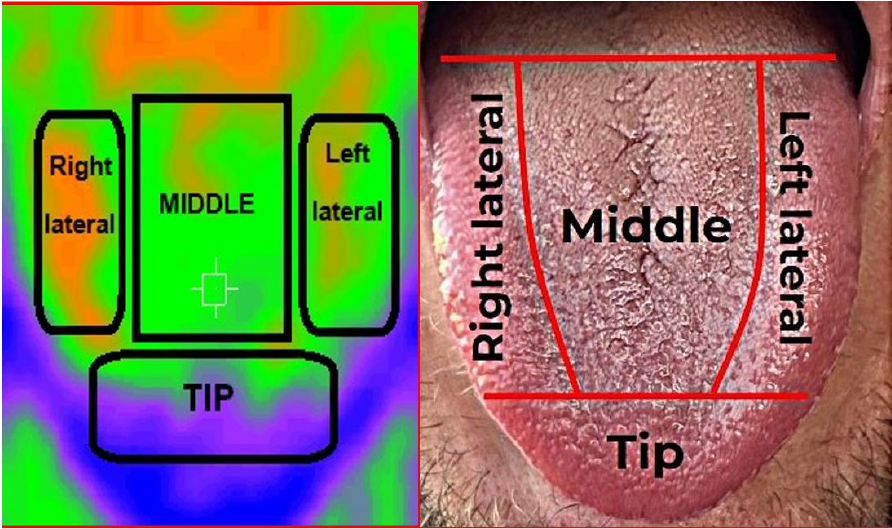
Figure 1. Illustration of the areas of the tongue surface and infrared thermal images. The tongue temperature recordings were made using a manual thermographic camera (model HT − 02D, Hti Dongguan Xintai Instrument Co., Ltd., Donggaun, China), with